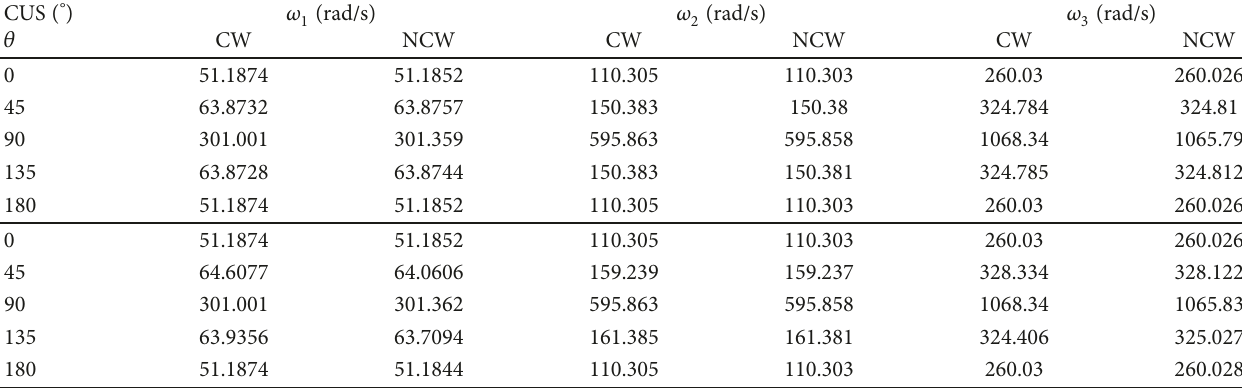
Table 8: Eigenfrequencies of Model A via CW and NCW for CUS and CAS.